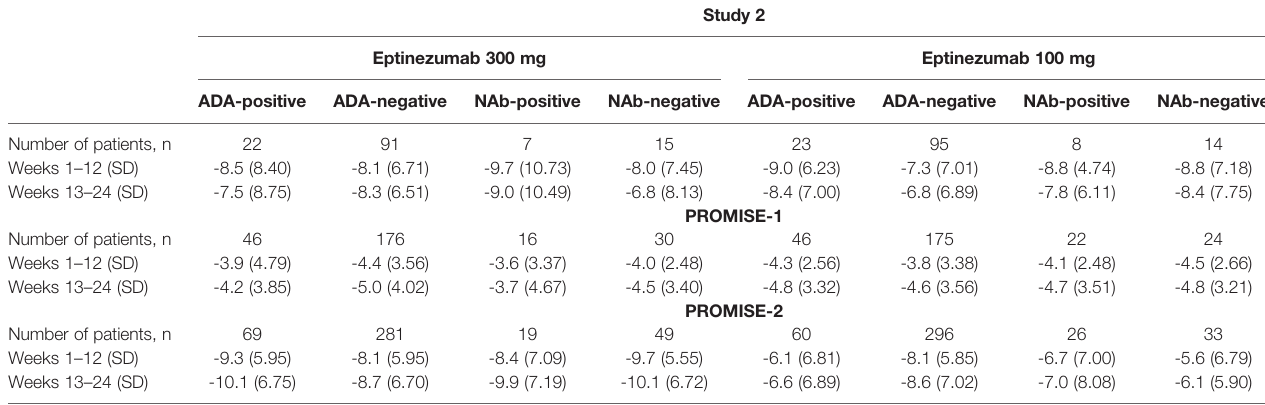
TABLE 5 | Change in monthly migraine days by ADA and NAb status in Study 2, PROMISE-1, and PROMISE-2 (full analysis